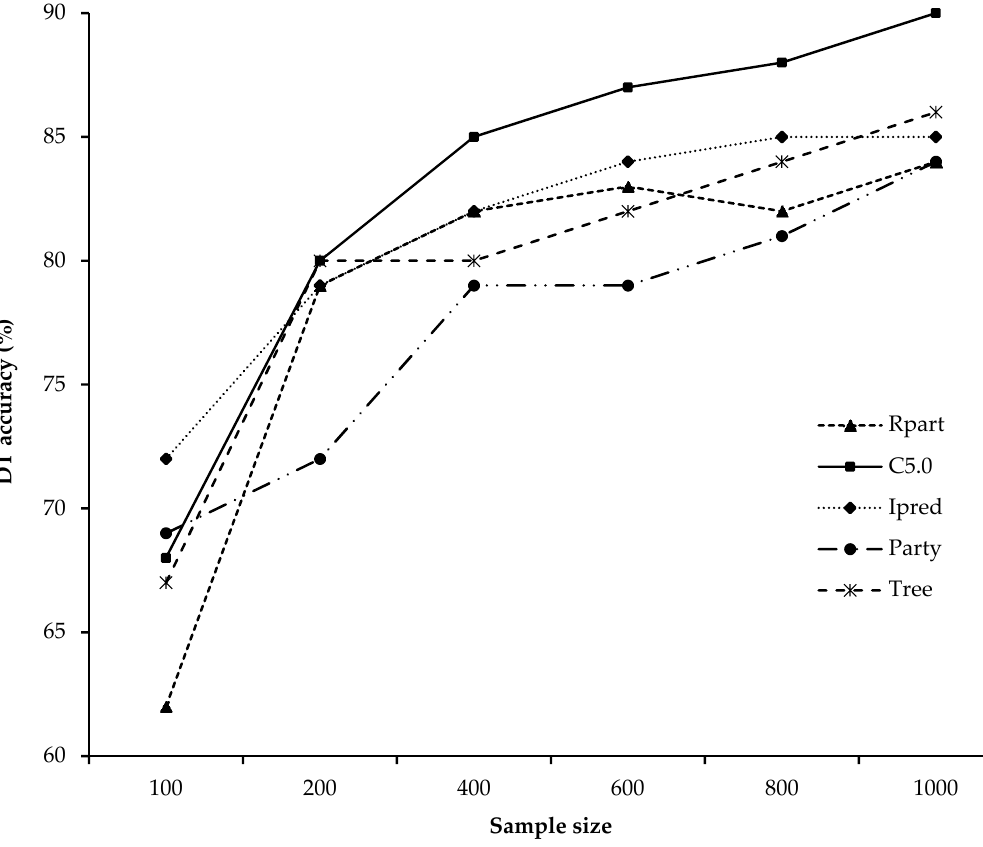
Figure 4. The accuracies of DT algorithms with increasing sample sizes.